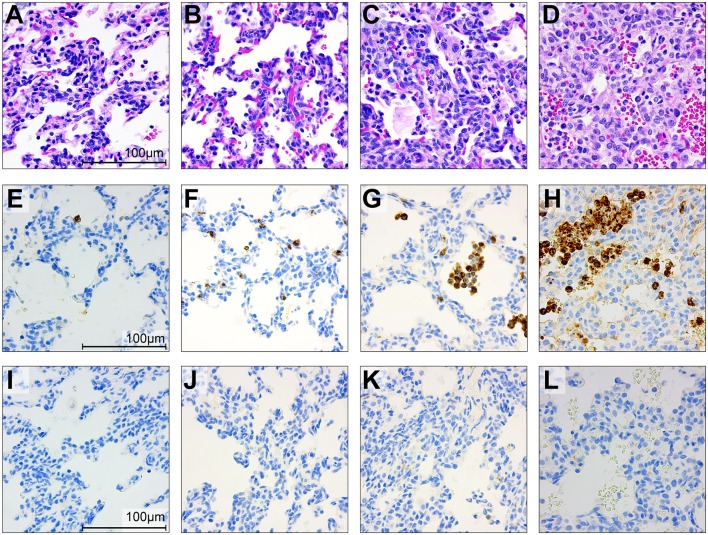
Histopathology and immunohistochemistry of the fetal lungs in saline controls (A,E,I), a GBS case delivered at 24 h (B,F,J) and 48 h (C,G,K) and with BSCI treatment (D,H,L). Staining for hematoxylin and eosin staining (A–D), MPO (E–H), and CD68 (I–L) was performed. In the fetal control lungs, there were few macrophages and rare neutrophils (A). GBS inoculation alone was associated with recruitment of neutrophils and macrophages, congestion and alveolar hemorrhage. Pre-treatment with the BSCI and GBS inoculation was associated with similar features, but greater neutrophil recruitment and more severe histopathologic features of pneumonia (D, 72 h after GBS inoculation). Immunostaining for MPO and CD68 demonstrated a subjective increase in MPO+ cells (H) in the BSCI treated vs. GBS alone group (F,G,J,K) at 72 h post-inoculation.